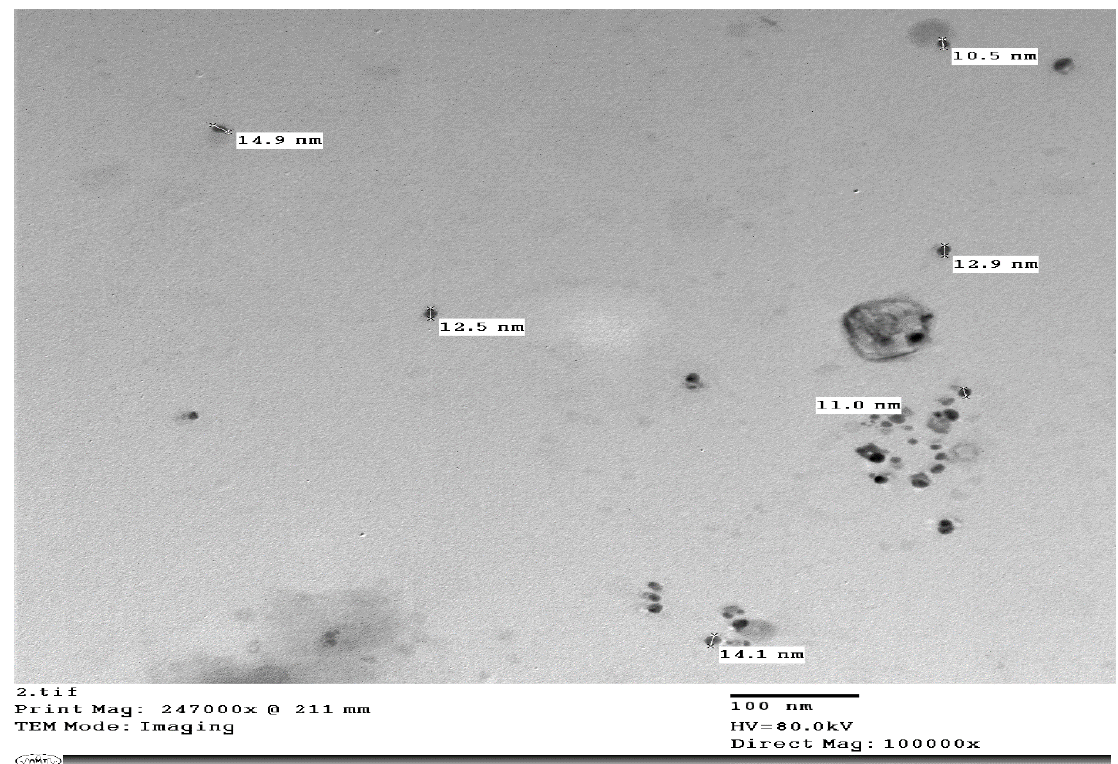
Figure 2. The AgNPs obtained from vanillic acid as seen by TEM. Particle size ranged from 11.0 nm to 14.1 nm.